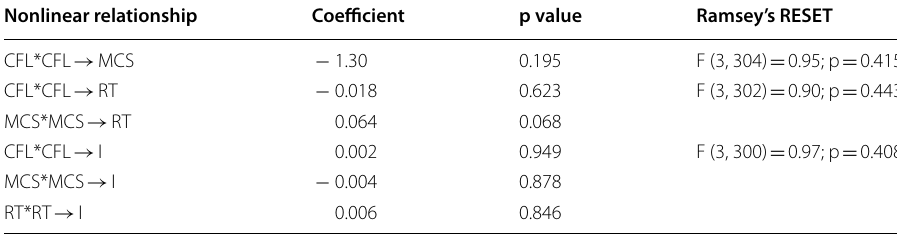
RT risk taking; MCS Management Control System; CFL CEO’s financial literacy; I technological innovation